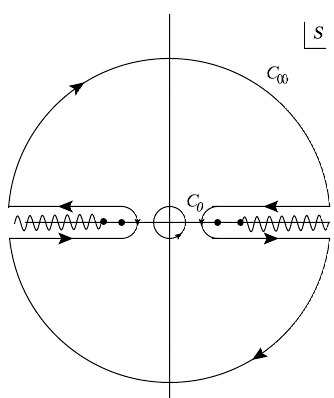
Figure 3 . We define the low energy couplings through a contour integral on the complex s - plane, where the contour C encircles the origin. On the complex plane, if the amplitude only has 0 singularities on the real- s axes, either poles or branch points, then we can deform to contour C